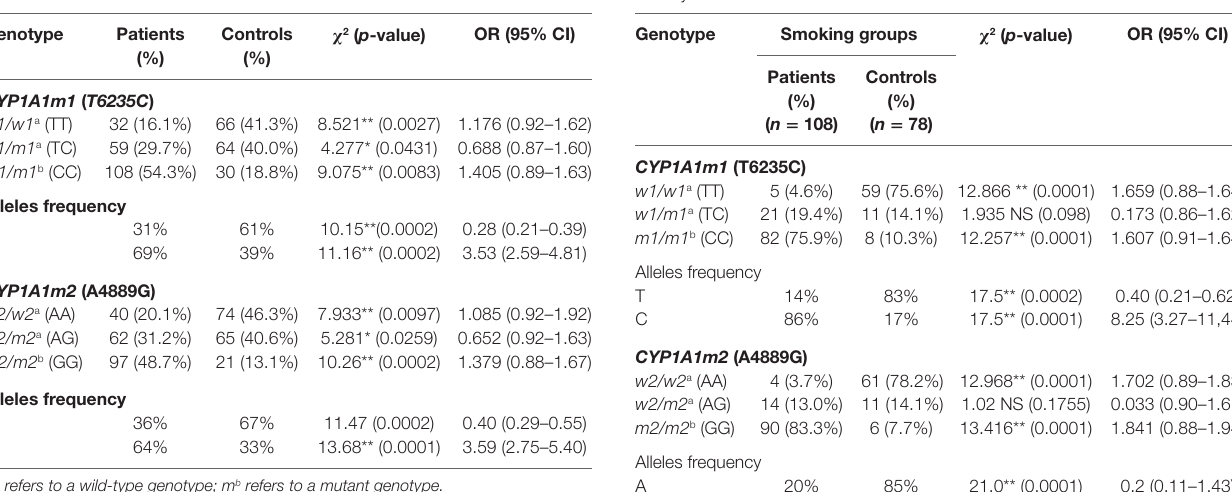
TaBle 3 | Association of tobacco smoking on the CYP1A1m1 and CYP1A1m2 genotype and allele frequencies among women with breast cancer (patients) and healthy controls.